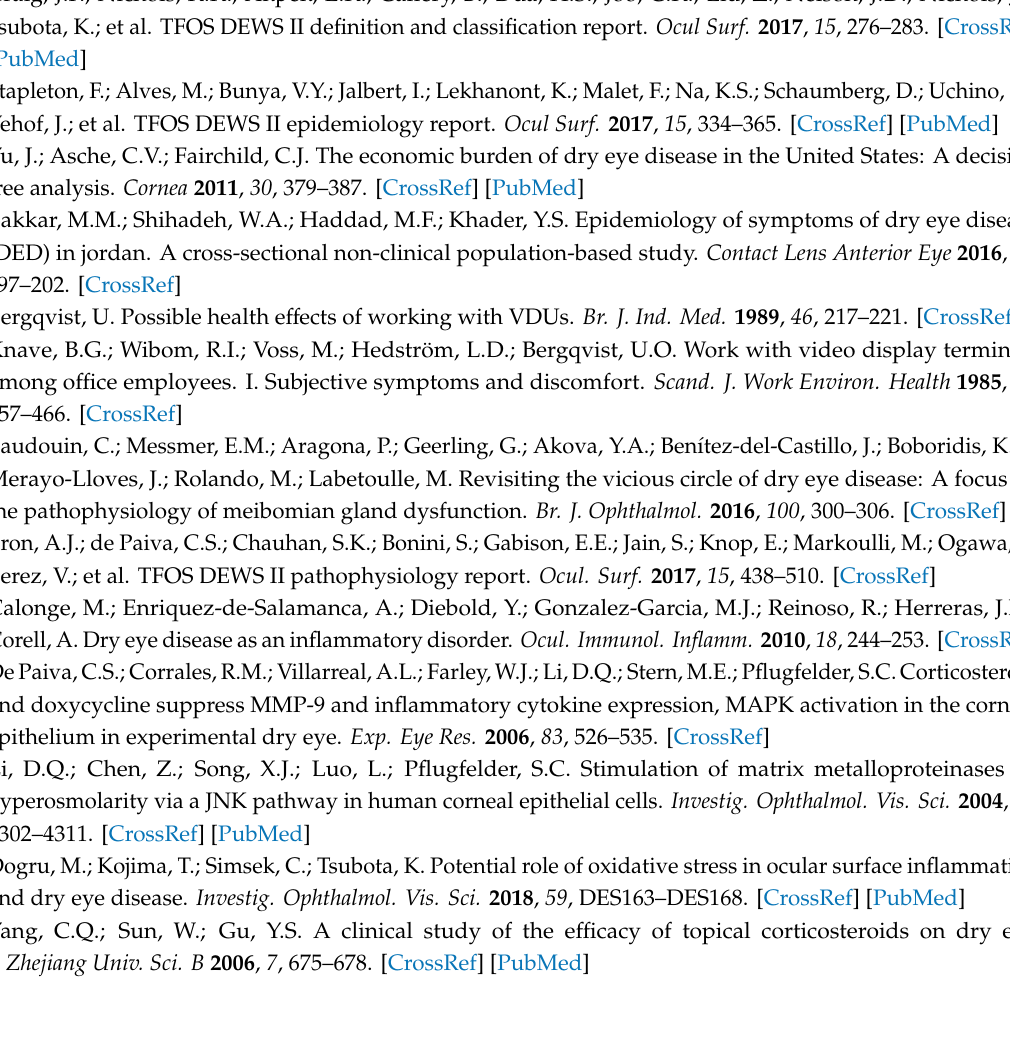
Figure S1: HPLC chromatograms of curcuminoids, Figure S2. HPLC Chromatograms of lutein and zeaxanthin, Figure S3. HPLC chromatograms of vitamin